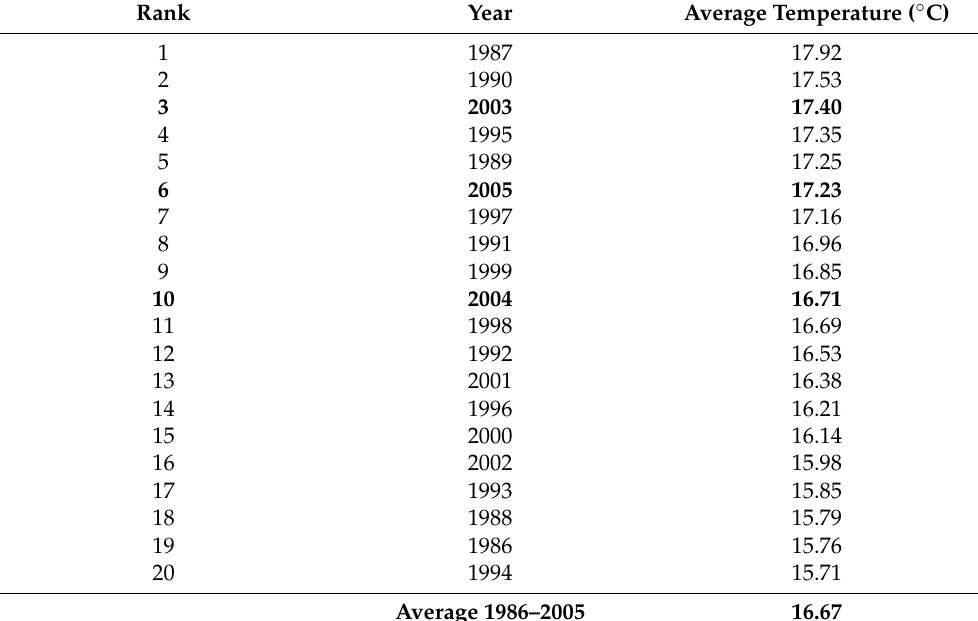
Table 2. Ranked Douro Demarcated Region (DDR) annual temperature (1 April–30 September)